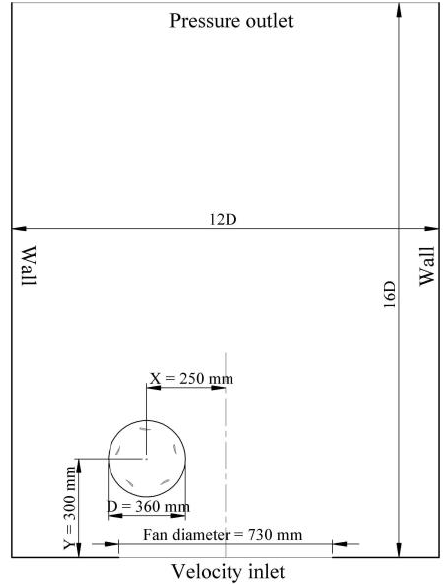
Figure 3. Computational domain